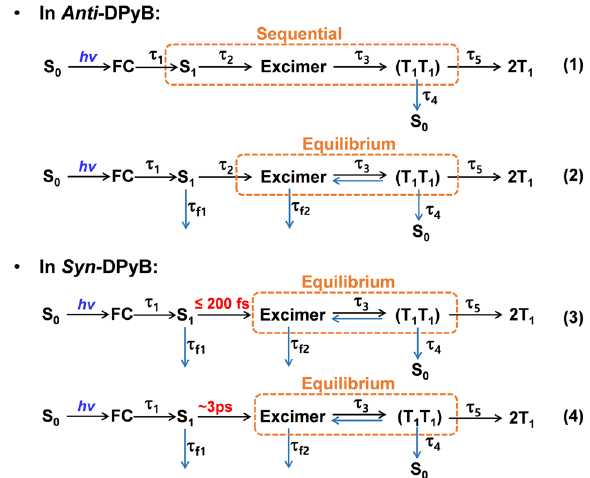
Fig. 4 Kinetic schemes for photoinduced reactions of Anti -DPyB and Syn - DPyB. S 0 : ground state, FC: Franck – Condon state, S 1 : singlet excited